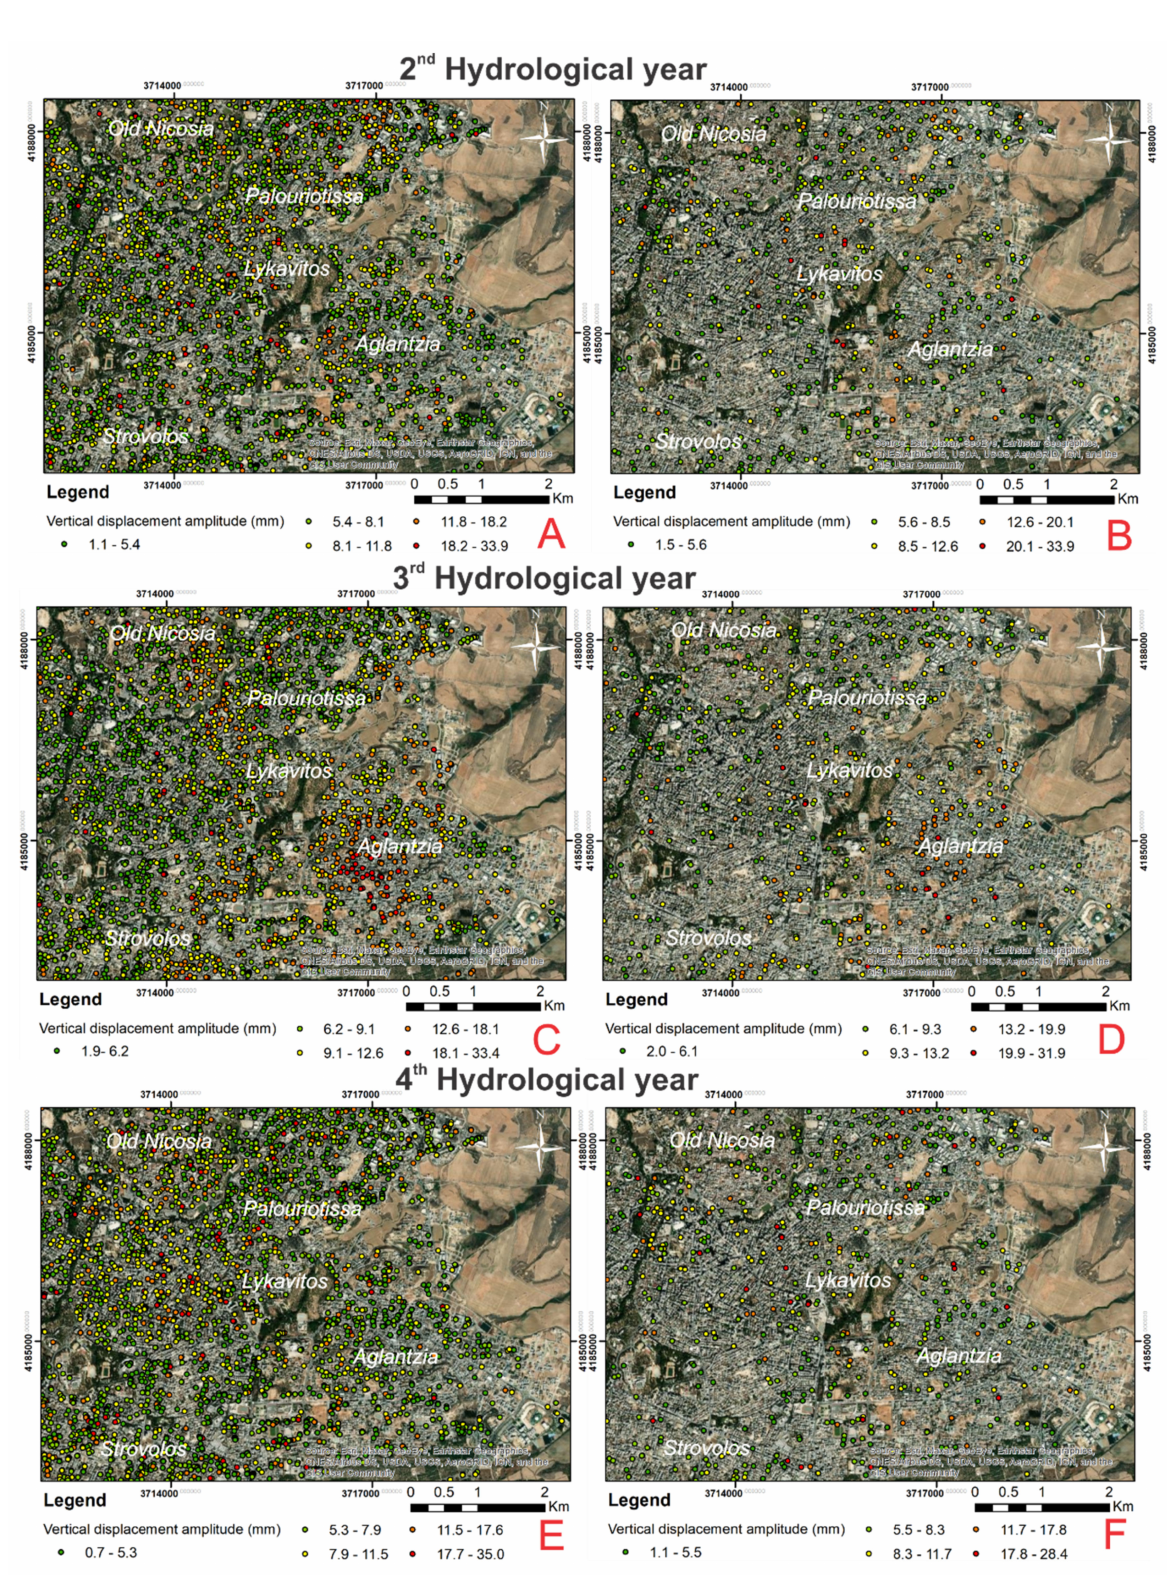
Figure 7. Spatial distribution of the vertical displacement amplitude for the 3 hydrological years: ( A , C , E ) PS points, ( B , D , F ) free field PS